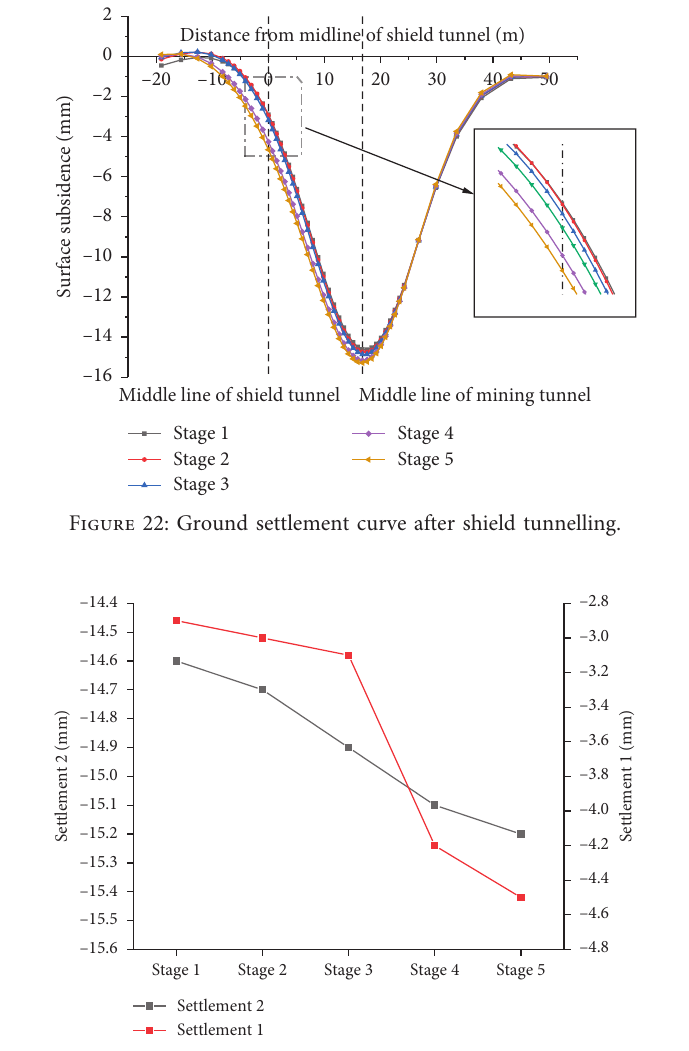
Figure 23: Surface settlement results.